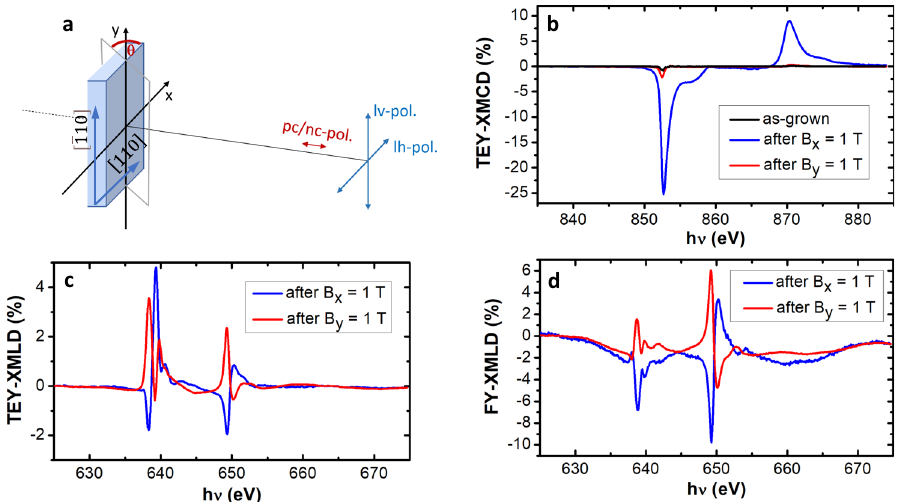
Fig. 3 XMCD/XMLD of Mn 2 Au(40 nm)/Py(4 nm)/SiN x (2 nm). Signal averaged over the x-ray illumination spot of ≃ 360 μ m 2 × 530 μ m 2 . a Experimental geometry showing the x-ray polarization directions and orientation of the Mn 2 Au(001) epitaxial thin fi lm. For measuring the XMCD with in-plane sensitivity, the sample is rotated by Θ = 60 ∘ around the y-axis. b TEY-XMCD at the Ni-L 2,3 -edge obtained with Θ = 60 ∘ . c TEY-XMLD at the Mn-L 2,3 -edge obtained from the difference between XAS recorded with linear horizontal (lh) and XAS with linear vertical (lv) x-ray polarization, Θ = 0 ∘ . d Bulk sensitive substrate FY-XMLD at the Mn-L 2,3 -edge, Θ = 0 ∘